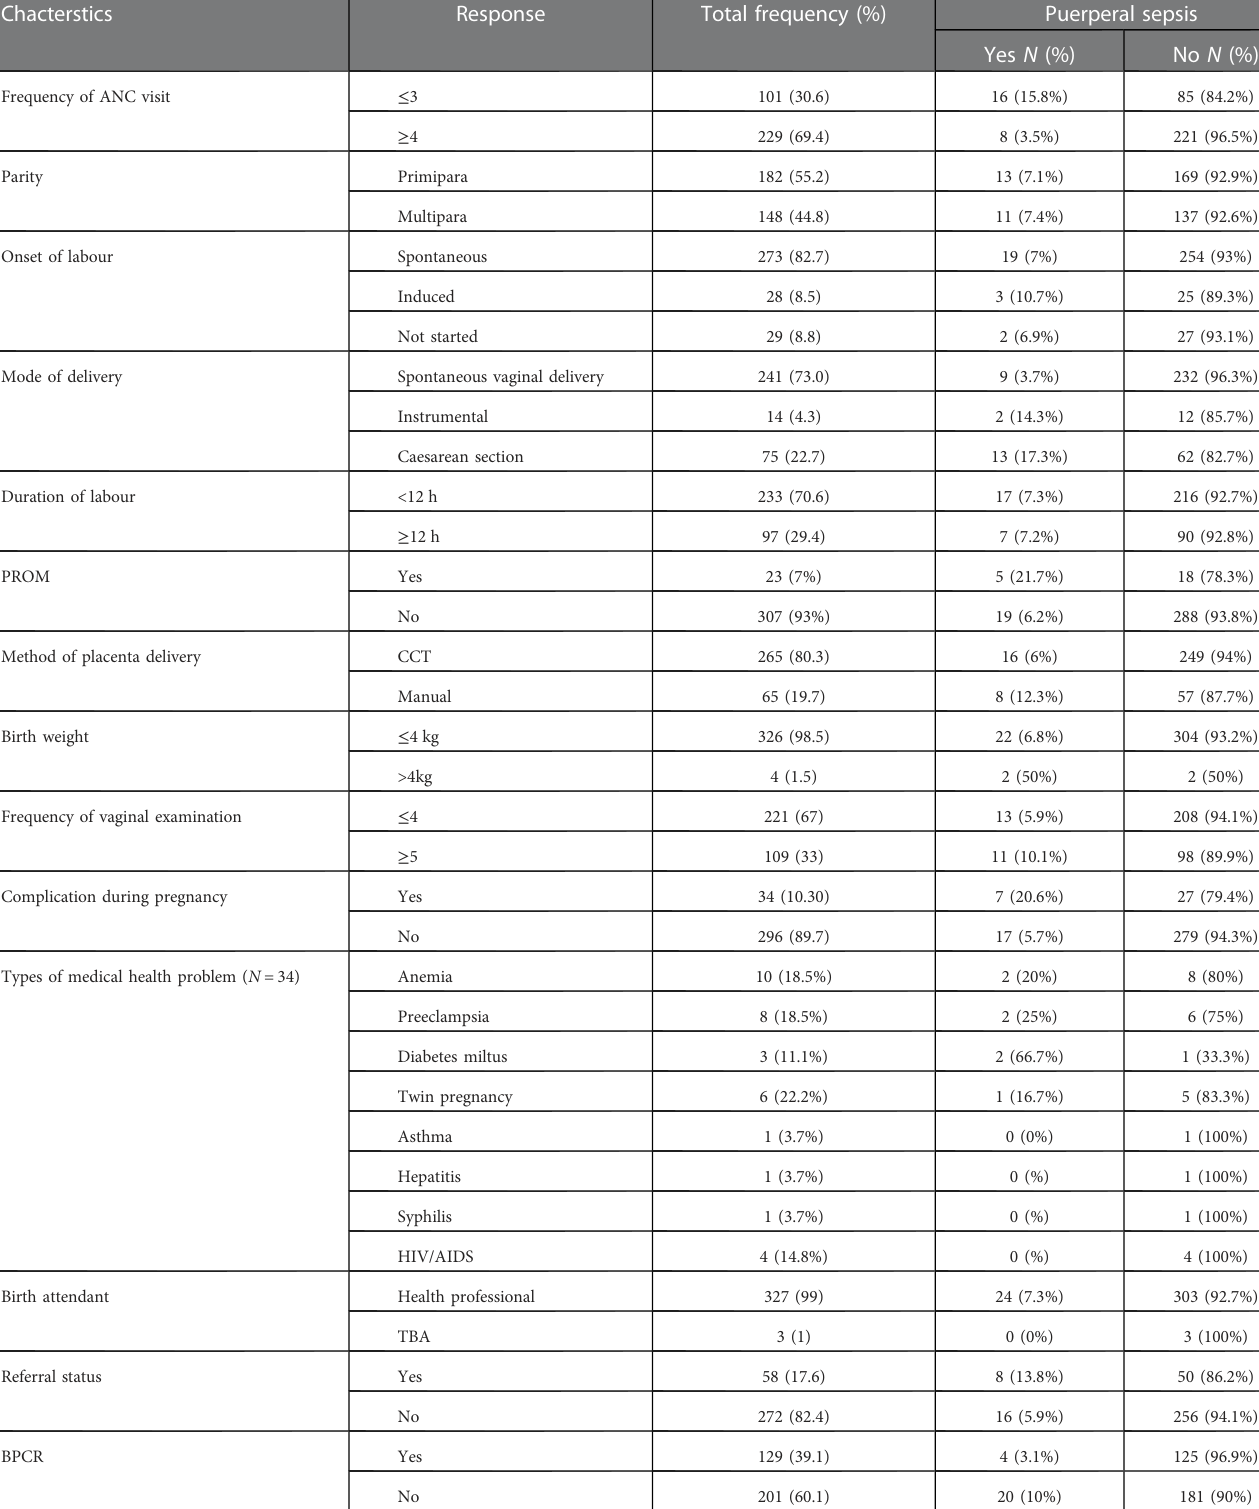
TABLE 2 Obstetrics history and health facility of study participants at DMCSH, Debre Markos, northwest Ethiopia, 2020/2021 ( N =330).